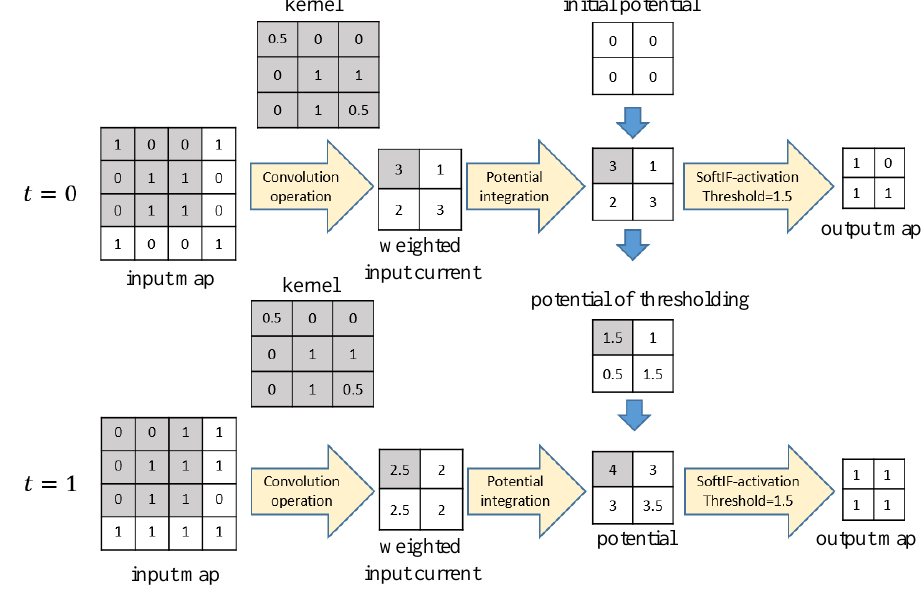
Figure 3. Convolution in an